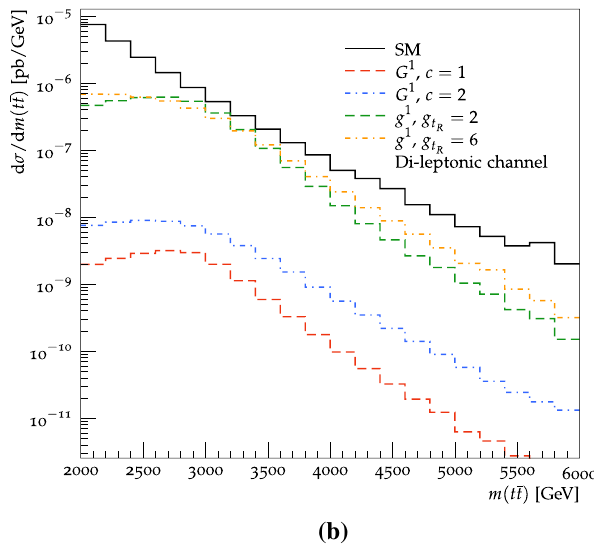
Fig. 1 Distributions of m ( t ¯ t ) for the semi-leptonic ( a ) and di-leptonic ( b )analysesforthebackgroundSM t ¯ t andsignalsamplesafterallanaly- sis selections and detector effects. Note that the semi-leptonic analysis